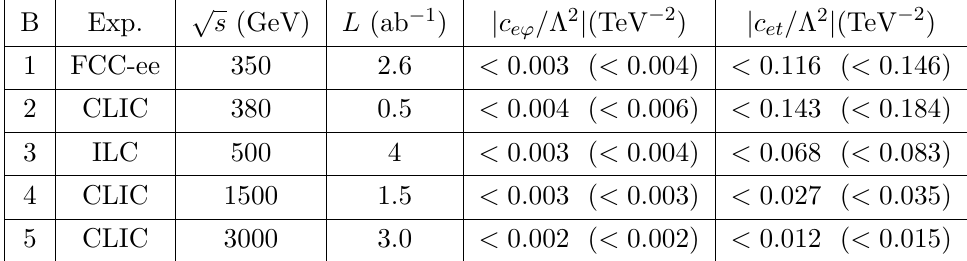
Table 1. Table of the di(cid:11)erent benchmark scenarios (B) considered in our analysis. Each bench- p mark consists of a speci(cid:12)c value of the center of mass energy ( s ) and luminosity ( L ) that has been proposed for the future e + e (cid:0) colliders. The last two columns represent the 95 % CL intervals for each operator coe(cid:14)cient taken individually in the analysis with k = 1 ( k = 0 :